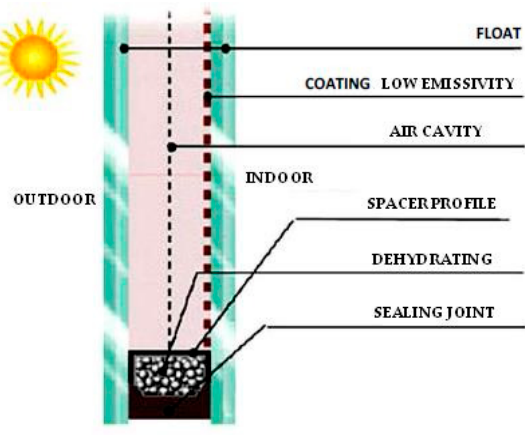
Figure 6. Operation of low-emissivity glass.